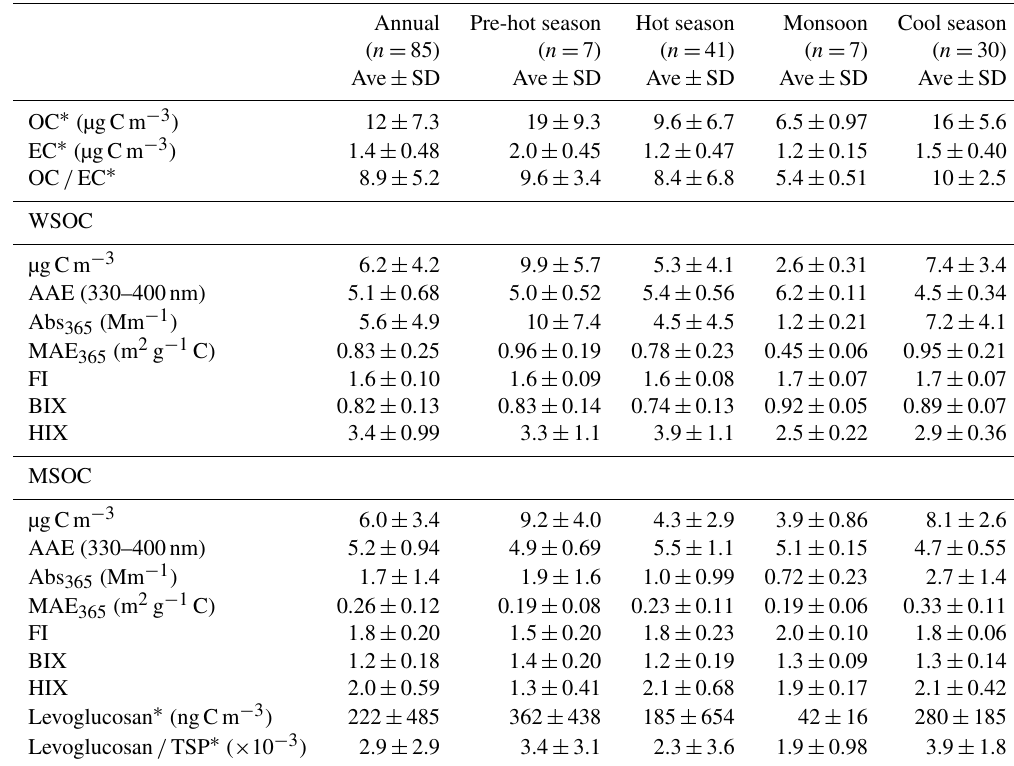
Table 1. Seasonal averages of the concentration of organic carbon (OC), elemental carbon (EC), water-soluble organic carbon (WSOC), and methanol-soluble organic carbon (MSOC), as well as BrC absorption, fluorescence indices, and levoglucosan levels for aerosol samples collected from Bangkok in Thailand. The pre-hot season is from 18 January to 29 February 2016, the hot season is from 2 March to 31 May 2016, the monsoon is from 2 June to 30 October 2016, and the cool season is from 1 November 2016 to 28 January